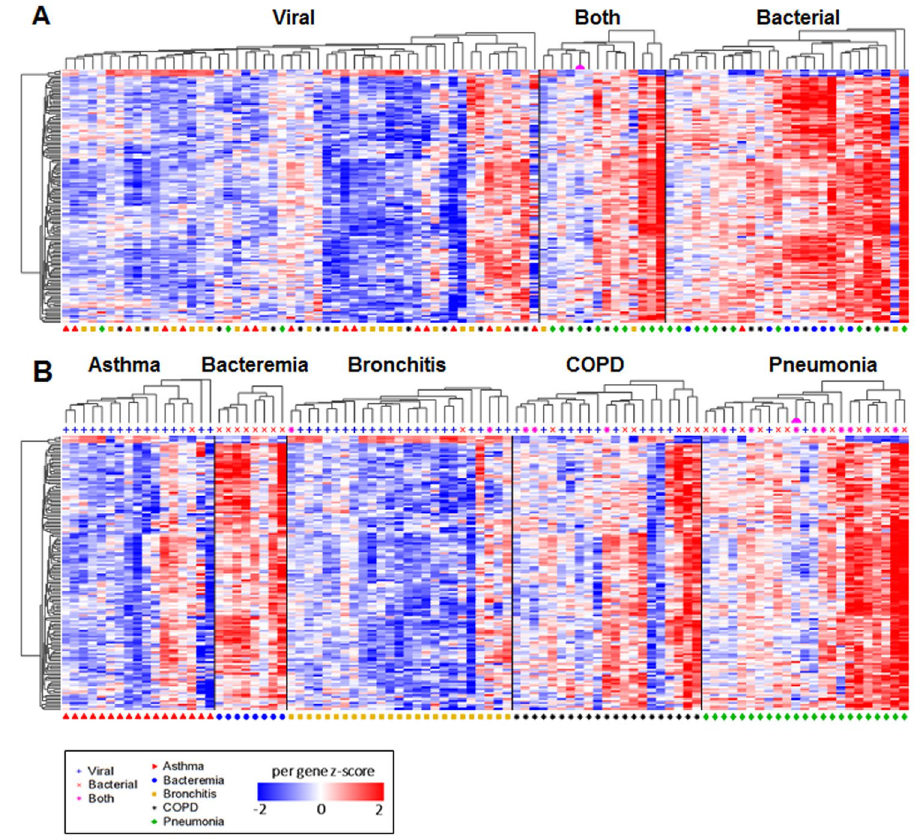
Figure 2. Global Expression Patterns in LRTI. ( A ) Shown is a heat map for the 141 genes (rows) demonstrating significantly different expression levels between bacterial and non-bacterial groups. Each column represents an individual subject, and subjects were grouped based upon microbiological diagnosis, using independent hierarchical clustering (Euclidean distance with average linkage). ( B ) The same data are presented, grouped by clinical diagnosis. The pink semi-circle denotes the patient with influenza A and a single blood culture positive for S . aureus